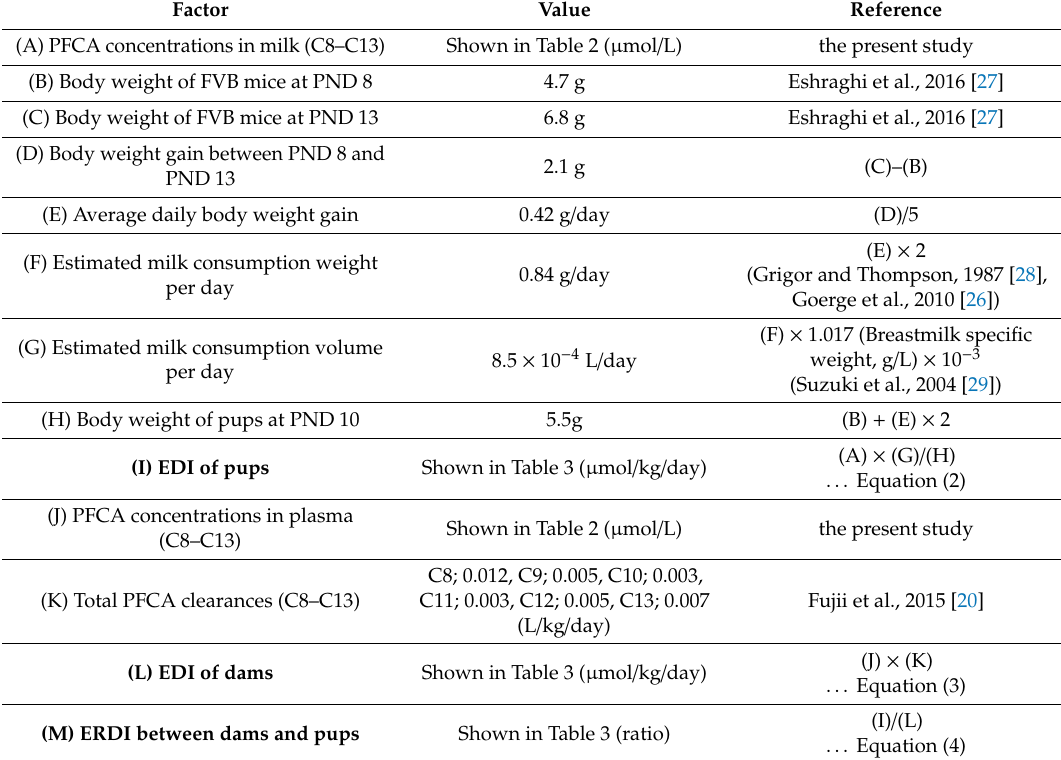
Table 1. Factors and values used to estimate doses to pups via lactation, and relative doses to pups from